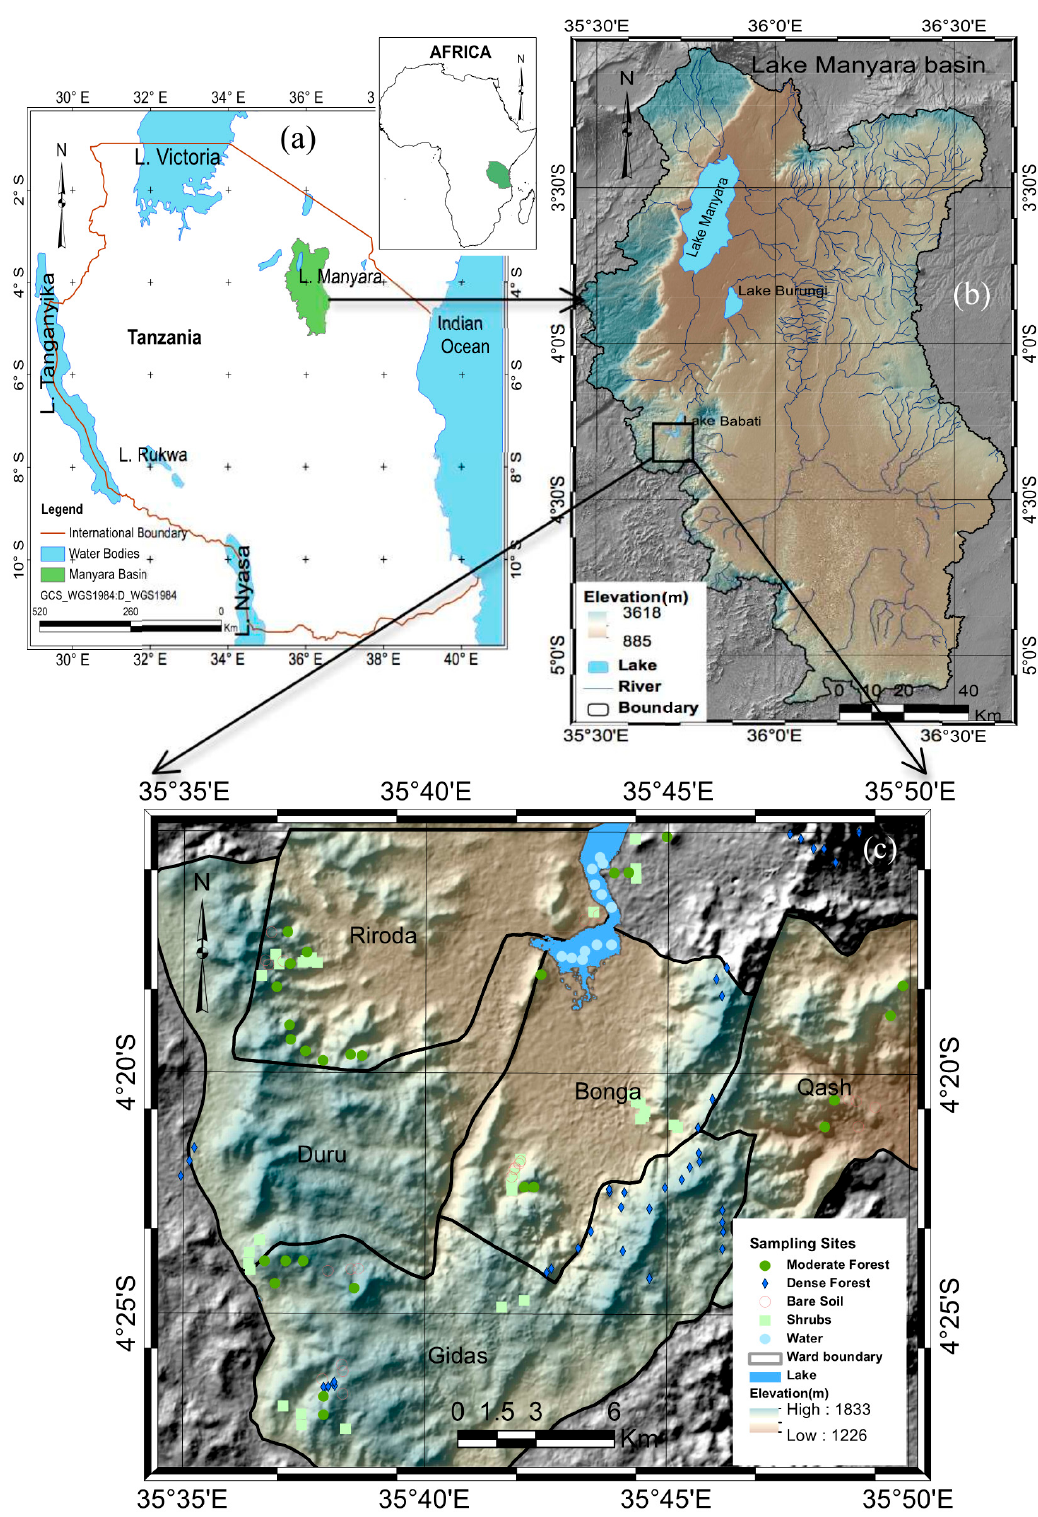
Figure 1. Study area: ( a ) Lake Manyara basin in northern Tanzania; ( b ) Lake Manyara basin; ( c ) Duru-Haitemba and Bereko forest reserve, with the distribution of sampling sites used for selection of training and validation datasets in five wards of Babati district in Manyara region.